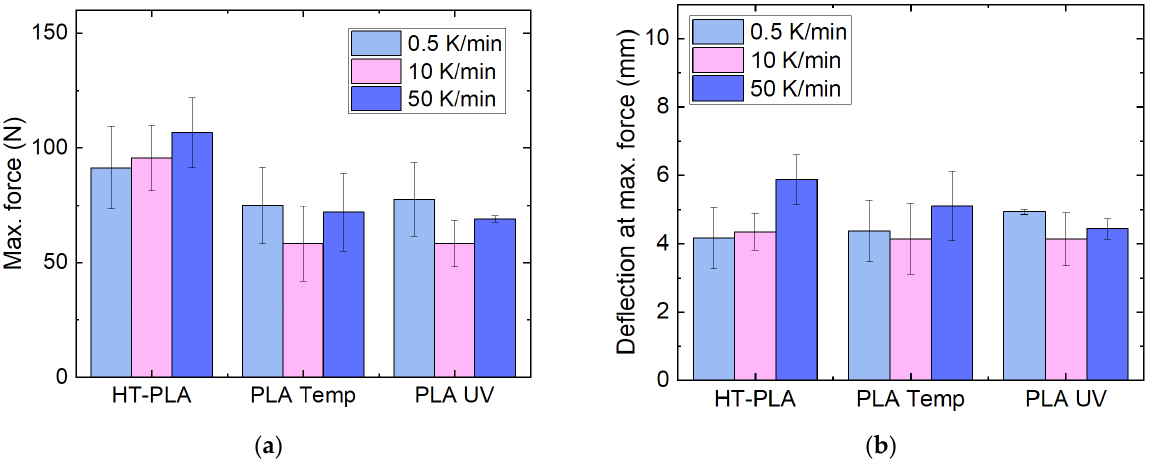
Figure 13. Mechanical properties of chosen PLA materials, heat-treated at 100 °C, approached with different heating rates: ( a ) maximum force; ( b ) deflection at maximum force in 3-point bending tests.